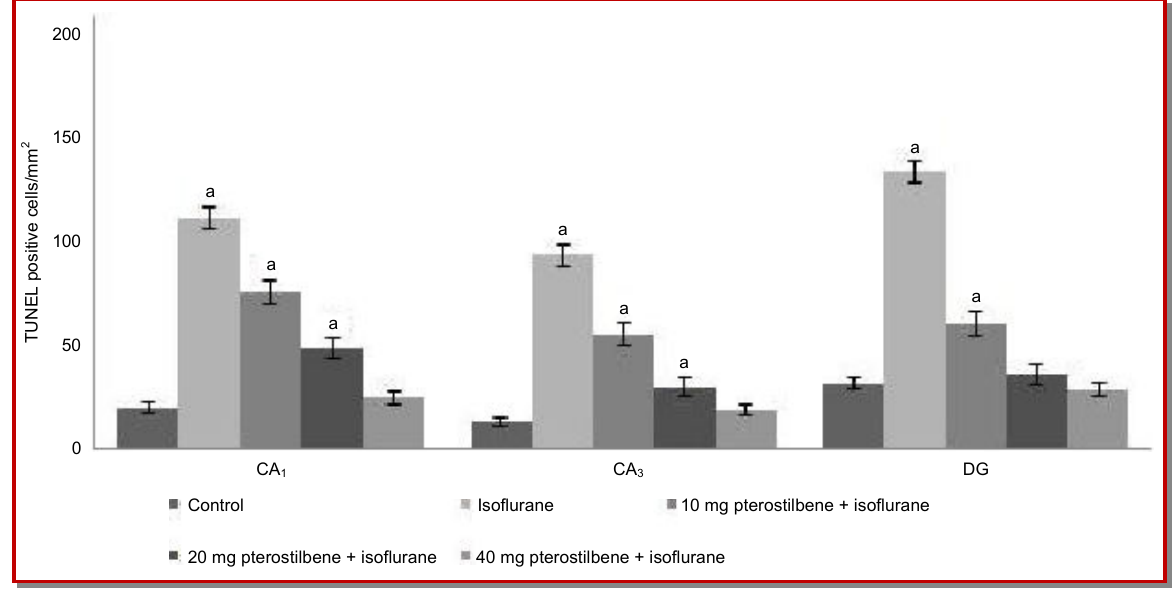
Figure 1: Influence of pterostilbene on isoflurane-induced neuroapoptosis Values are represented as mean ± SD, n=6. a represents statistical significance at p<0.05 compared against control as determined by one-way